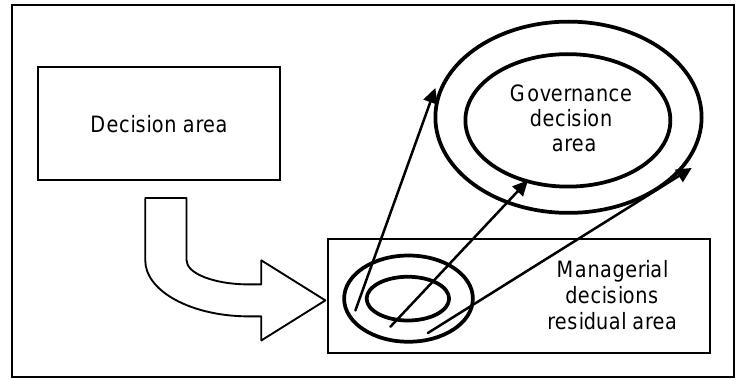
Figure 2: The Extrapolation of the Governance ‘Decision’ Area from the Whole ‘Decision’